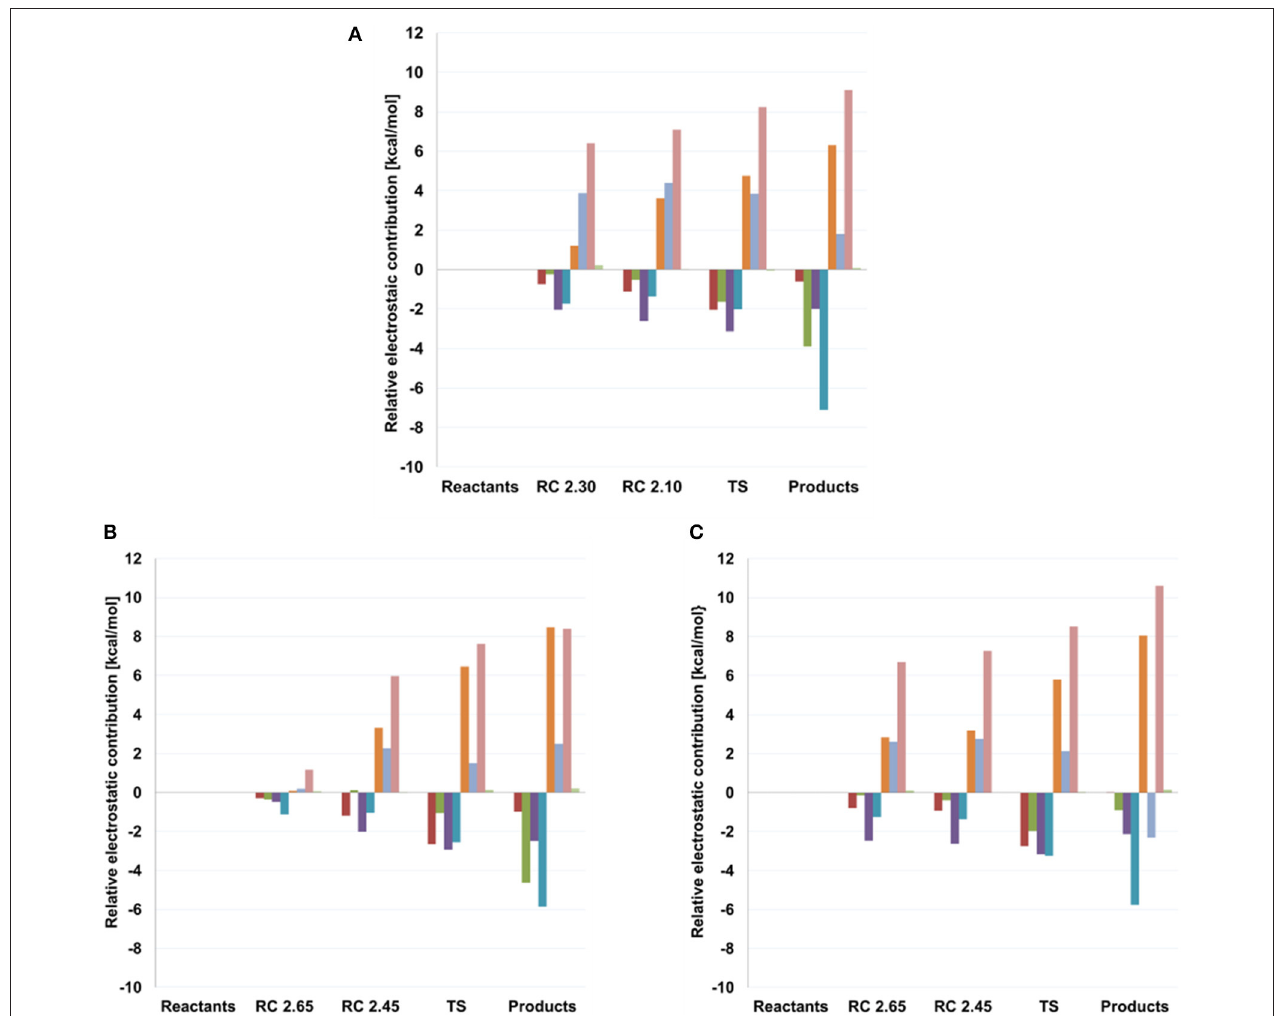
FIGURE 7 | Electrostatic Interaction Analysis (in kcal/mol) of residues in the − 1 subsite for (A) hydrolysis and both transglycosylation (B) T I and (C) T II frames studied in this work. Calculations were performed on the structures obtained with QM(small)/MM and at the QM = (PBE0/TZVP) level. Values, with respect to reactant, are given at different points along the reaction coordinate (RC), the transition states (TS) and products. Red: HIS 119, dark green: GLN 18, purple: ASN 163, dark blue: ASN 282, orange: TYR 284, light blue: GLU 392, pink: ARG 75, light green: CYS